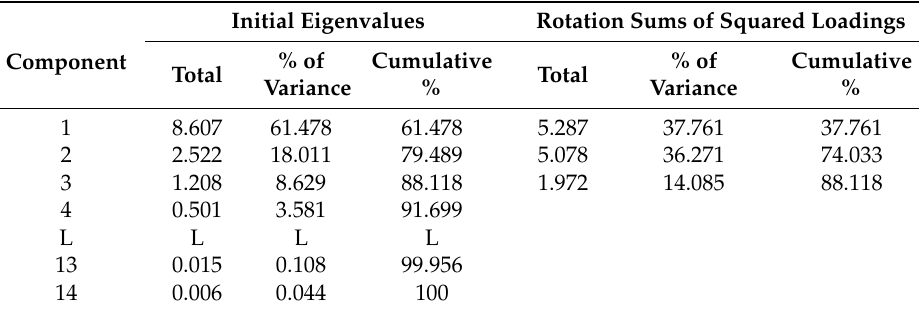
Table 3. Total variance explained of sustainable capacity of auxiliary